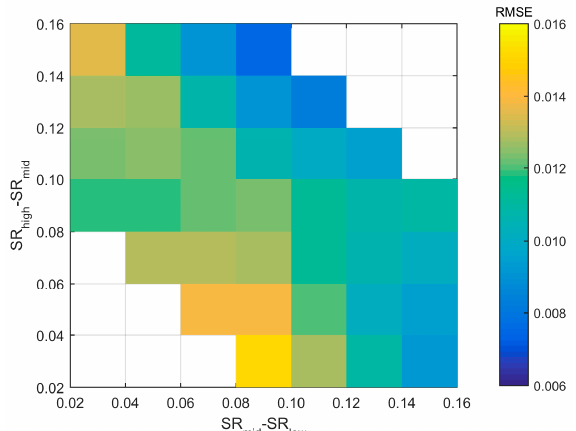
Figure 6. RMSE for different surface reflectance differences. SRlow, SRmid, and SRhigh are the lowest, middle, and highest reflectance among the participating pixels (environmental parameter setting: solar zenith angle = 30°, sensor zenith angle = 50°, relative azimuth angle = 120°, AOD = 0.8).